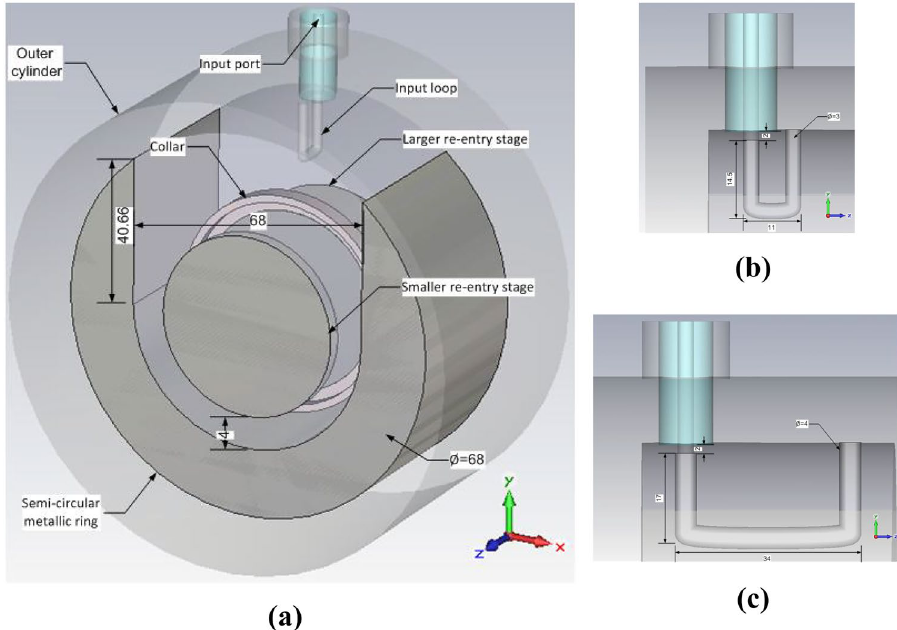
Figure 6. Geometry of optimised cylindrical re-entrant resonant cavity exposure system with a semi-circular metallic ring for impedance matching (all lengths are in mm); ( a ) Components of the cavity; ( b ) Dimensions of smaller loop for the excitation of unloaded cavity; ( c ) Dimensions of larger loop for the excitation of loaded